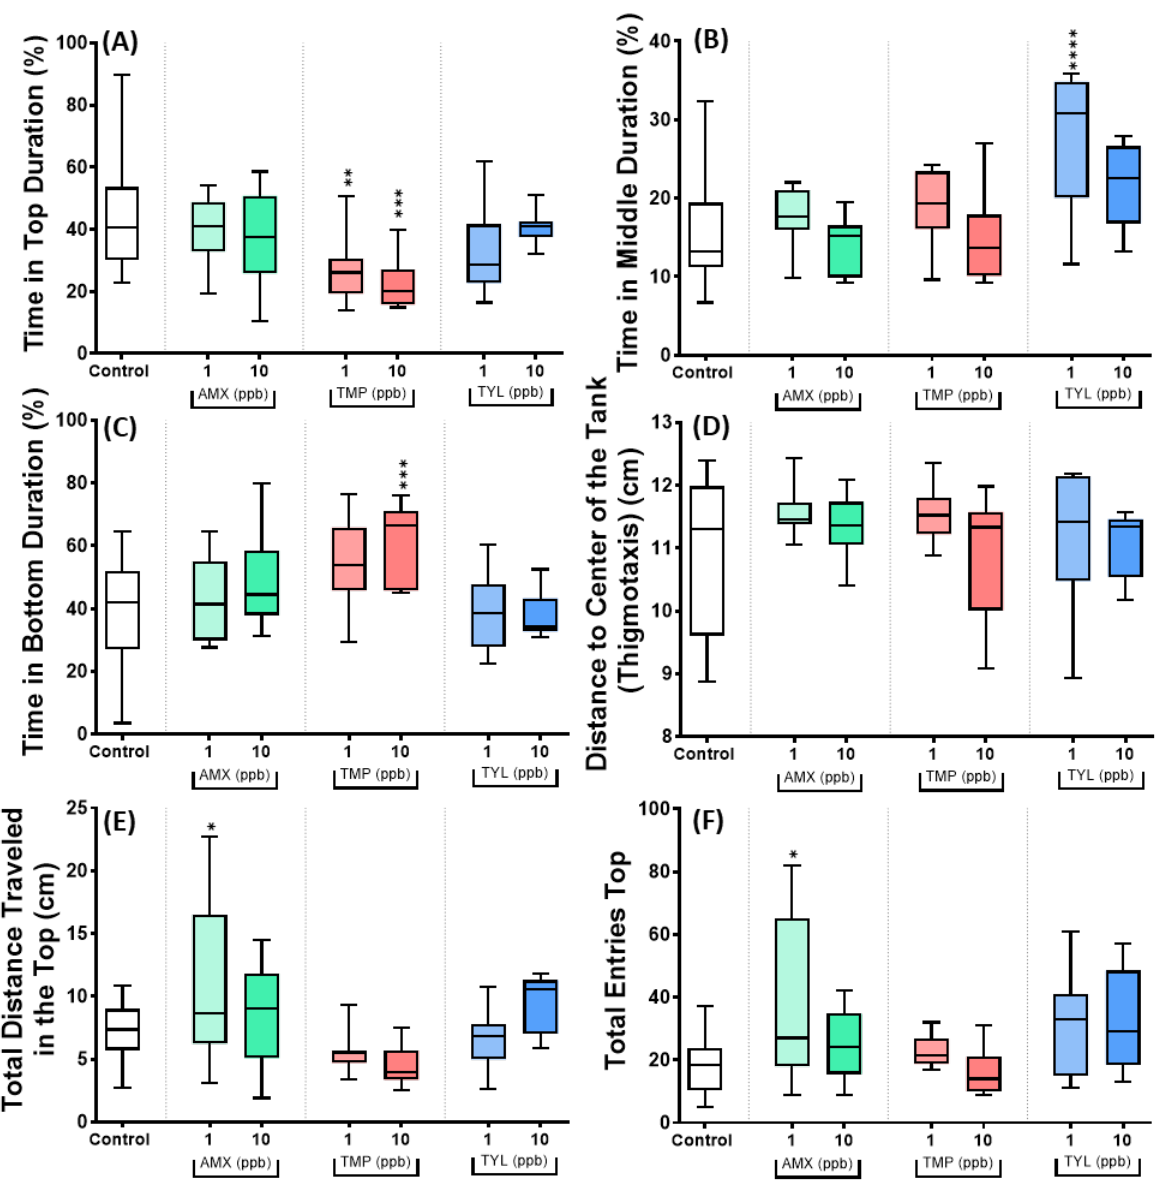
Figure 7. The exploratory behavior of control and antibiotic-treated golden zebrafish after 10 days of exposure. ( A ) Time in top duration (%); ( B ) time in middle duration (%); ( C ) time in bottom duration (%); ( D ) distance to the center of the tank (thigmotaxis) (cm); ( E ) total distance traveled in the top (cm); and ( F ) total entries top. The data are expressed as mean ± S.E.M and were analyzed by one-way ANOVA followed by Dunnett’s test ( n control: 12, n for antibiotic groups: 12, except n for AMX 1 ppb and TMP 10 ppb: 11, and n TYL 10 ppb: 10). The significances were indicated by * p < 0.05; ** p < 0.01, *** p < 0.001, and **** p < 0.0001 when compared to control group.